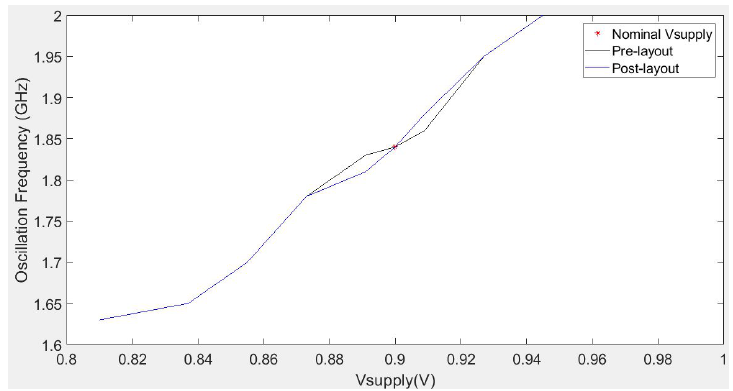
Figure 20. Frequency variations produced by the changes in the supply voltage of the